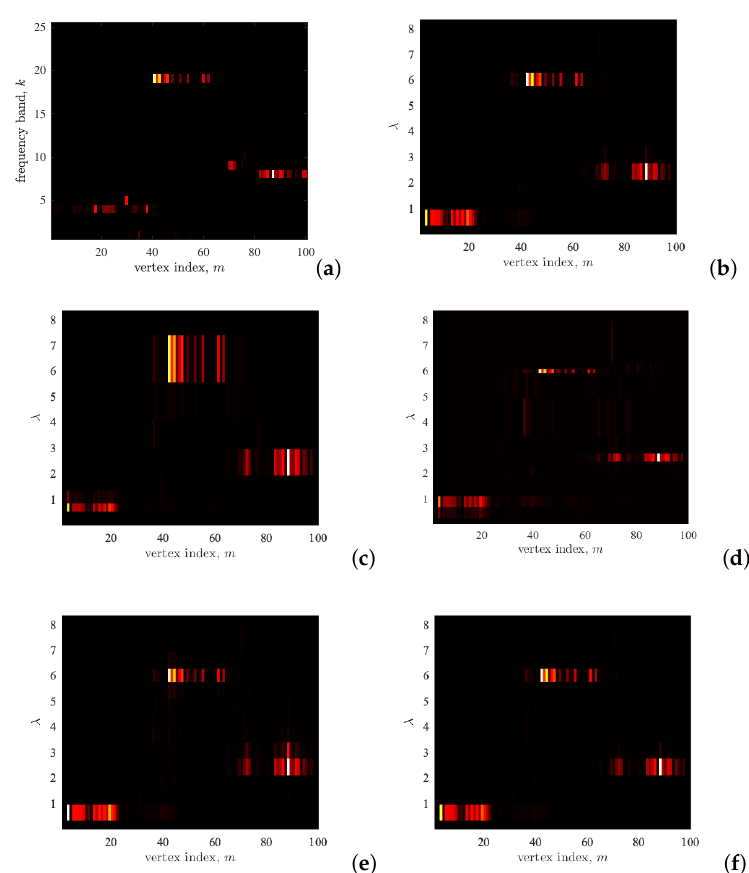
Figure 11. vertex–frequency representation of a three-component general graph signal from Example 1, shown in Figure 3 (bottom). The LGFT is calculated based on: ( a ) the transfer functions in Figure 5, ( b ) the transfer functions in Figure 9a, ( c ) the wavelet-like spectral transfer functions in Figure 9b, ( d ) the signal adaptive transfer functions from Figure 9b, ( e ) Chebyshev polynomial-based approx- imations from Figure 9d, with M = 20 and ( f ) Chebyshev polynomial-based approximations from Figure 9d, with M =